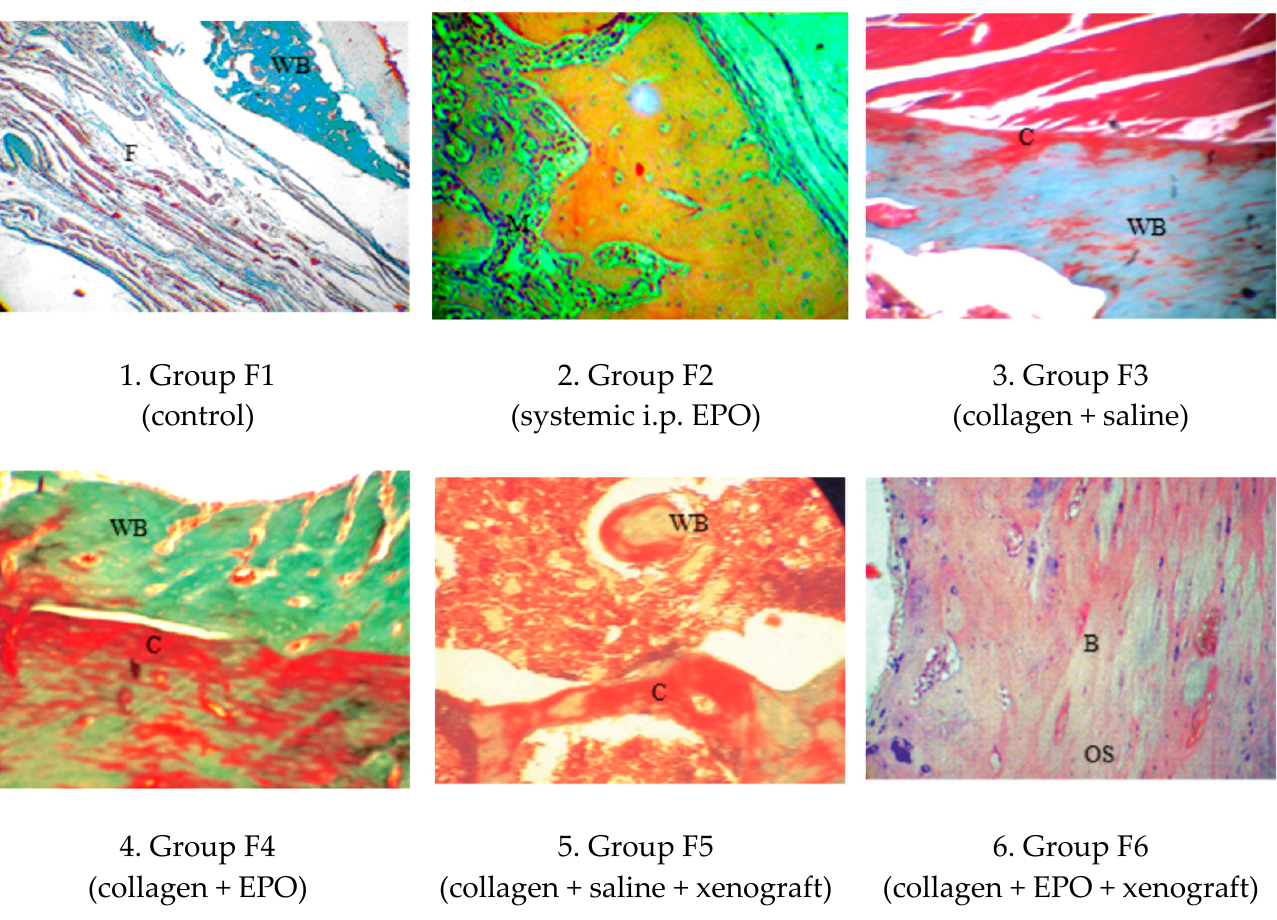
Figure 9. Histological patterns of rat femur segmental defects in different study groups on day 30. (1) Muscle and collagen fibres (F) surrounding a scarce woven bone (WB), MT × 100; (2) mesenchyme (M) is directed from the periphery towards the centre of the defect, H&E × 125; (3) newly formed woven bone (WB) and neovascularization, MT × 125; (4) contact between the collagen cone (C) and the newly formed woven bone (WB), MT × 125; (5) collagen cone (C) and woven bone (WB), undergoing transformation into lamellar bone, MT × 125; (6) the newly formed bone matrix (B) with osteocytes (OS) residing in lacunae, H&E ×